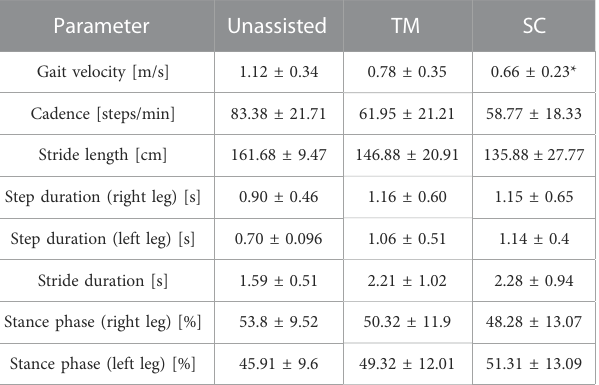
TABLE 1Spatiotemporal gait parameters calculated by the 3D-motion analysis system Vicon for all experimental conditions assessed: Unassisted, Transparent Mode (TM), and Stance Control (SC) (mean ± std). Asterisks indicate signi fi cant differences from the unassisted condition (Bonferroni, p <